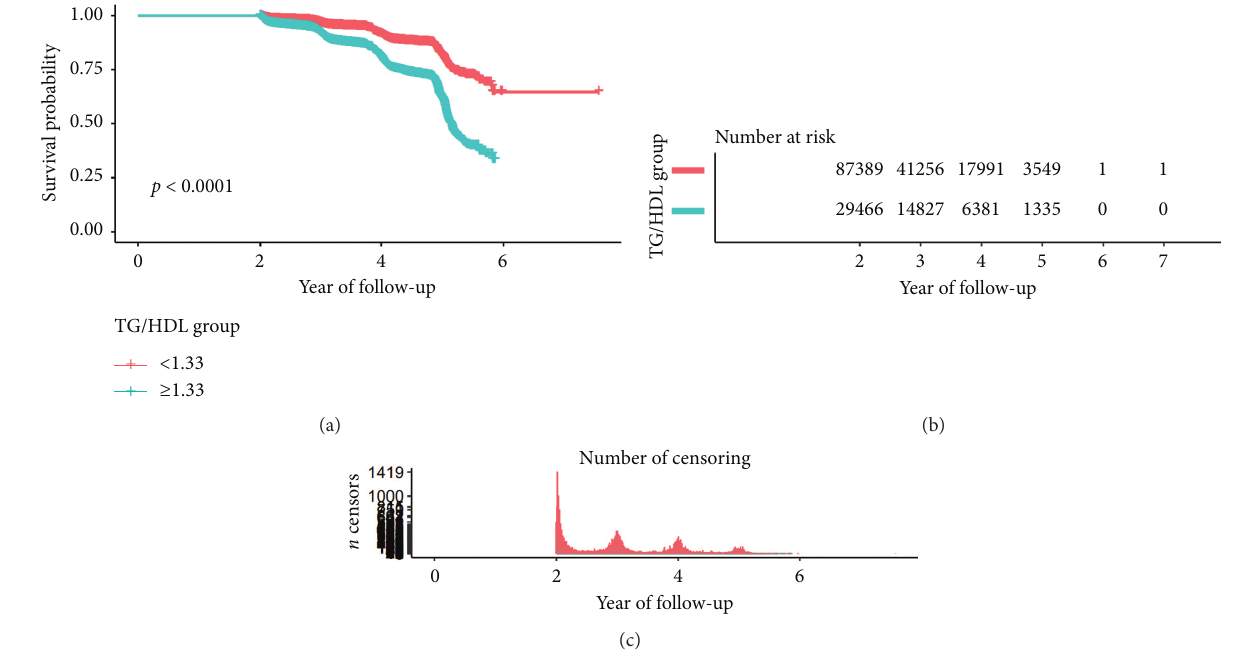
Figure 5: Survival analysis of diabetes mellitus with TG/HDL